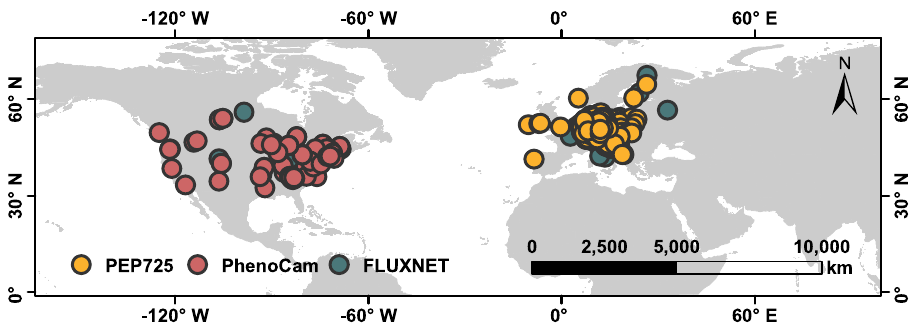
Fig. 1 Distributions of the phenological observation sites in this study. Orange dots represent the 2322 sites selected from the PEP725 dataset across central Europe. Pink and green dots represent 67 sites in North America from the PhenoCam network and 28 FLUXNET sites, respectively.